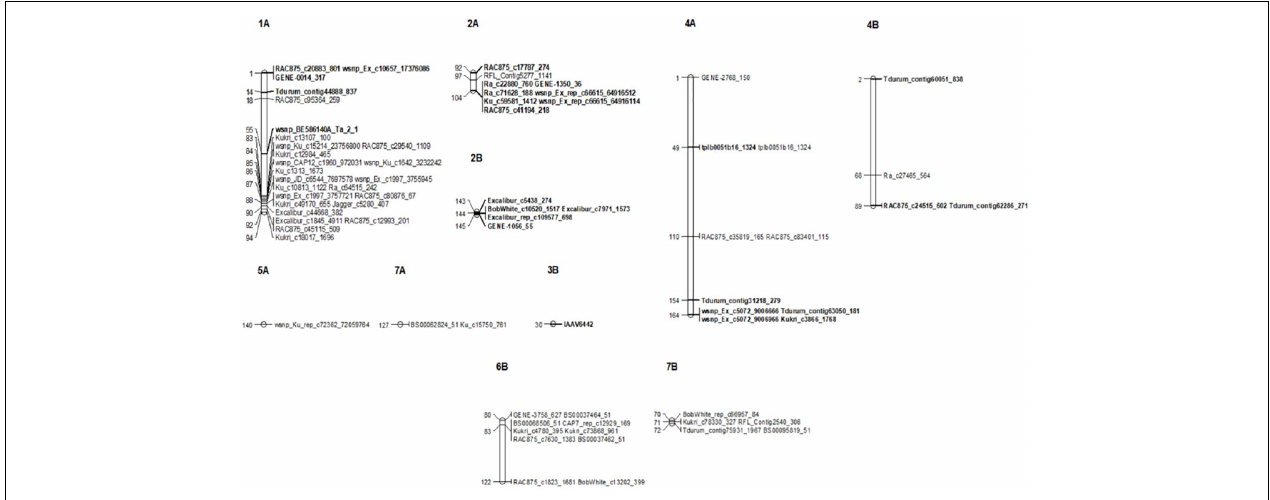
FIGURE 5 | Genetic linkage map of significant SNP markers associated with seedling (SRT) and the adult plant stage (APS) resistance to STB. Markers are shown on the right and genetic distances (cM) are shown on the left. Markers in bold represent markers detected at